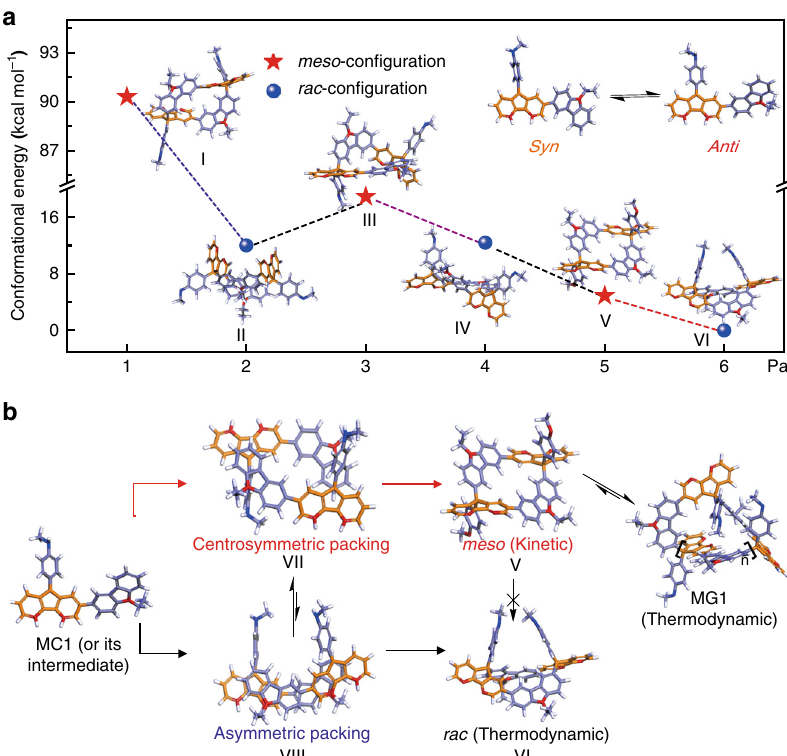
Fig. 5 The plausible gridization mechanisms. a The relative energies of the DHG1 products with different conformations (from individual reaction pathways). The relative energy of anti – anti -conformational rac -DHG1 is de fi ned as 0 kcal mol − 1 . Both I and II consist of two syn -conformational MC1 substrates; both III and IV consist of an anti -conformational MC1 and a syn -conformational MC1; both V and VI are composed of two anti - conformational MC1 substrates. The red stars and blue beads represent the meso -con fi gurations and the rac -backbones, respectively. b The gridization mechanism of